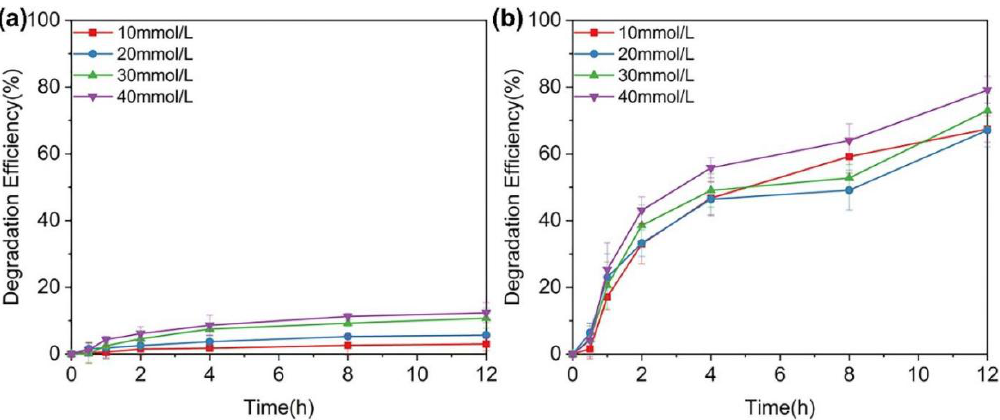
Figure 8. The degradation of β -D-glucose (n = 3): ( a ) single core–sheath fiber membrane; ( b ) com- posite fiber